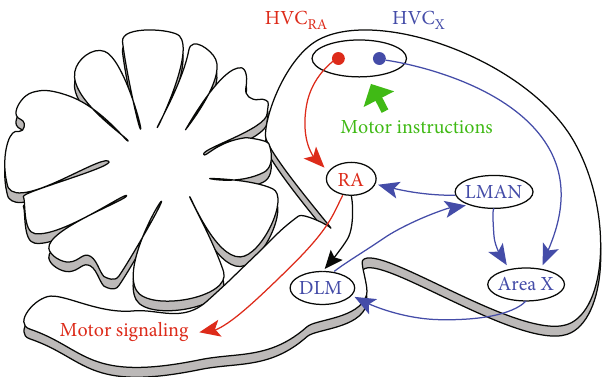
Figure 1: Neural structure of birdsong neural circuit. The red arrows indicate the song premotor pathway from HVC to RA. Similarly, the blue arrows indicate the anterior forebrain pathway (AFP) consisted of areas X, DLM, and